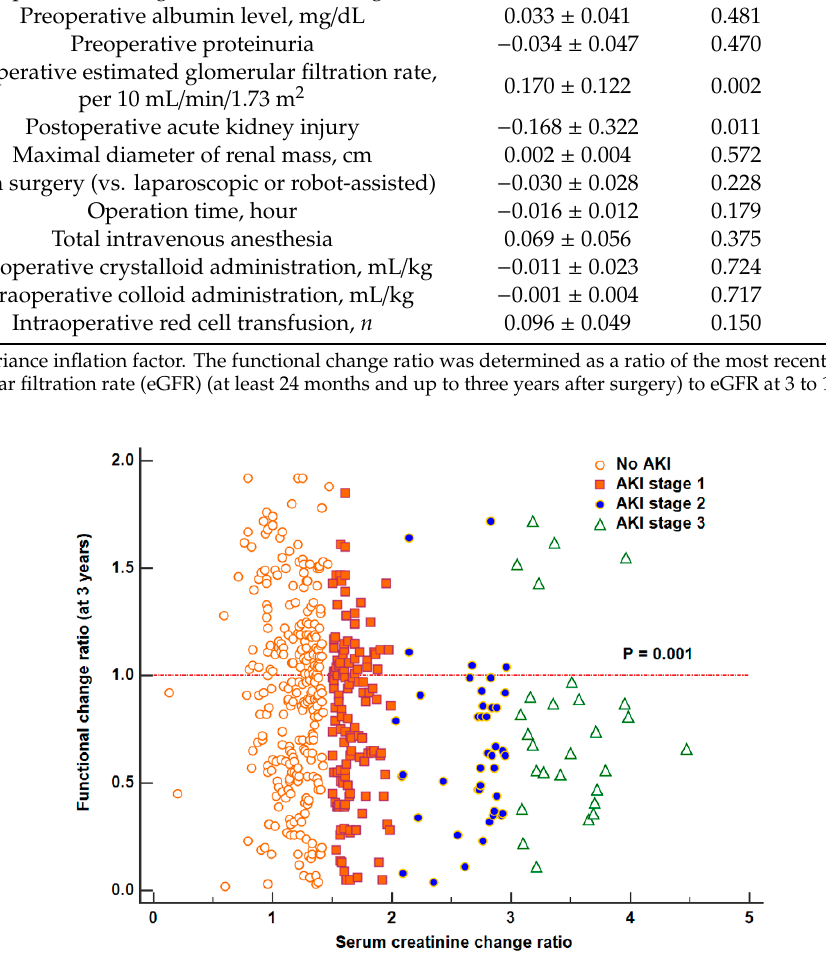
Figure 4. Distribution of the long-term functional change ratio across the different creatinine ratios which were used to determine acute kidney injury stages. There was a significant correlation between the functional change ratio and creatinine change ratio from baseline ( p < 0.001).